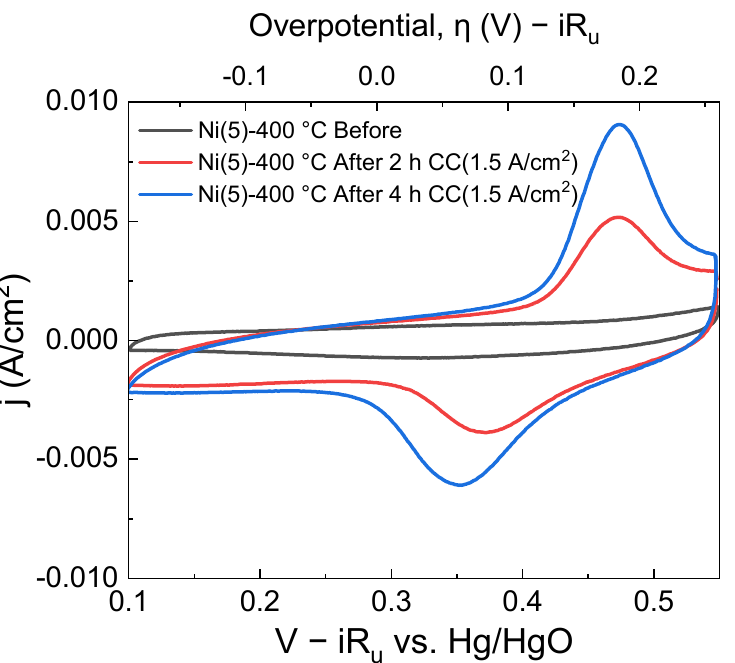
Figure 3. Cyclic voltammogram of a Ni(5)-400 ◦ C, taken before CC(1.5 A/cm 2 ) operation (black), after 2 h CC operation (red), and after 4 h CC operation(blue). With each subsequent CV cycle, CV Oxidation/reduction peak area increases.